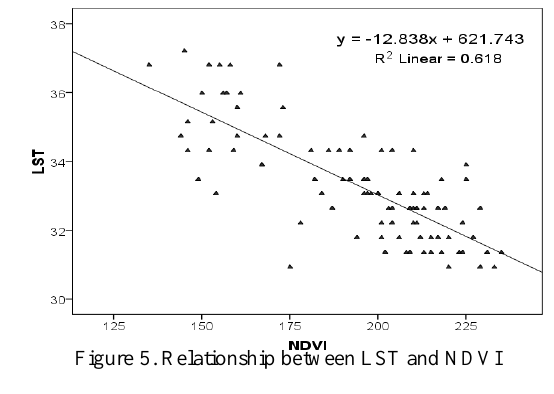
Figure 5. Relationship between LST and